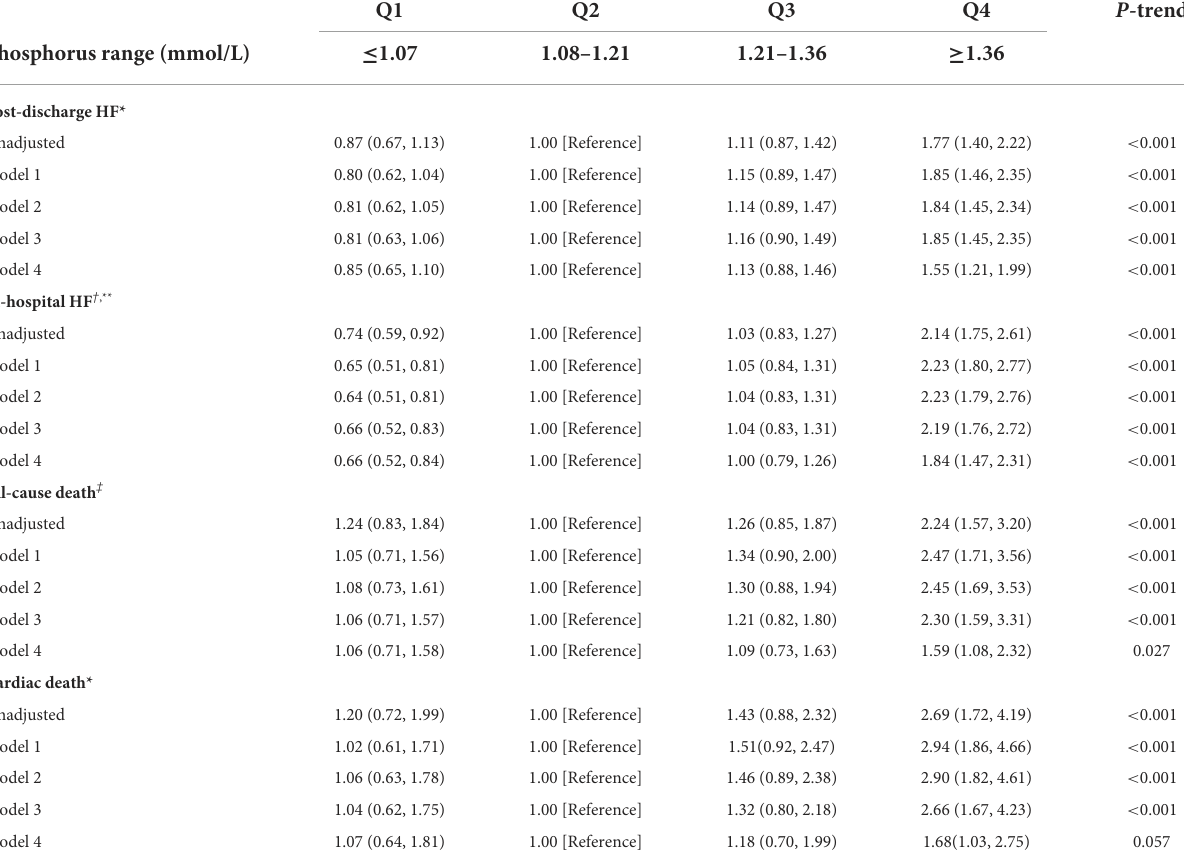
TABLE 3 Sub-distributional HRs, ORs, or HRs (95% CIs) associated with serum phosphorus for clinical outcomes after acute myocardial infarction. Q1 Q2 Q3